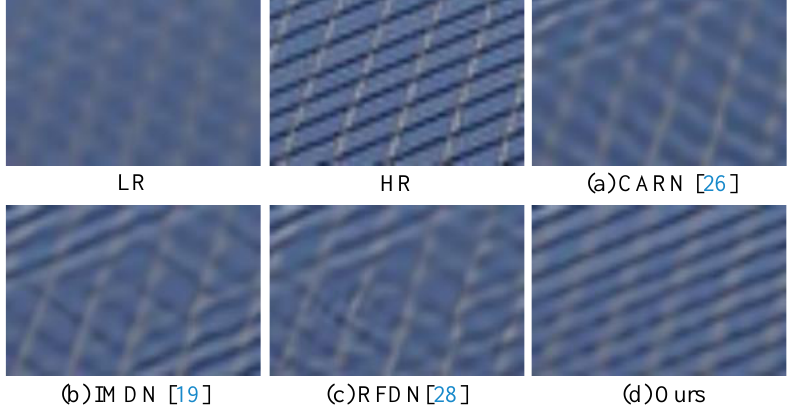
Figure 1. Visual results for × 3 SR on “img074” from Urban100. Our method obtains better visual quality than other SR